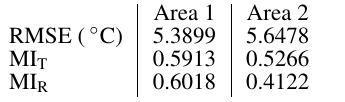
Table 1. Root mean squared error (RMSE) and mutual information (MI) of the measured and simulated temperatures and LWIR images respectively.